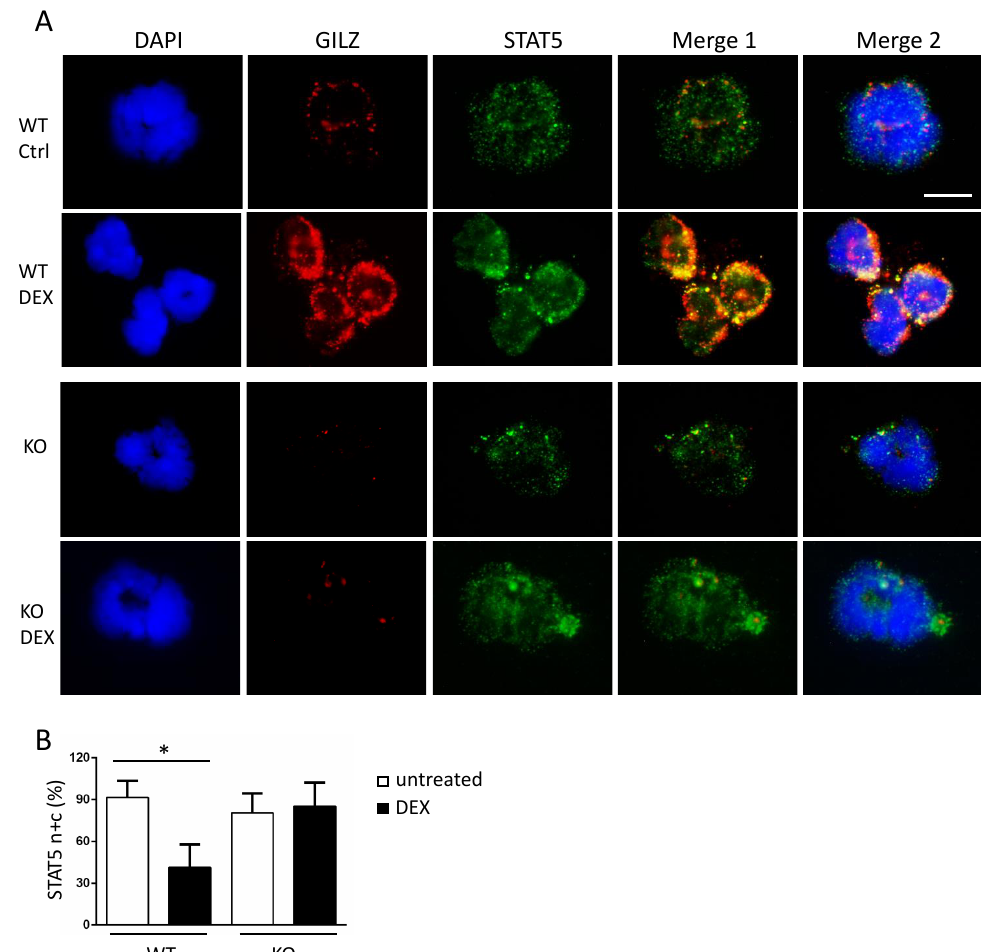
Figure 3. GILZ and STAT5 staining overlaps in mouse neutrophils. ( A ) Isolated peripheral WT and KO neutrophils were spotted on slides after 3 h of in vivo DEX treatment. The nuclei were stained with DAPI. Cytoplasmic and nuclear STAT5 (green) and cytoplasmic GILZ (red) staining showed overlapping spots (yellow, Merge 1) in DEX-treated cells (middle panels). Overlapping staining of STAT5, GILZ, and DAPI is shown in Merge 2. GILZ staining was absent in KO neutrophils (lower panels). ( B ) Cells with both cytoplasmic and nuclear (n + c) STAT5 staining were counted and expressed as a percentage of total cell number. Values represent mean ± SD. Scale bar, 10 µ m. All experiments were repeated three times. The results of a representative experiment are presented. * p <